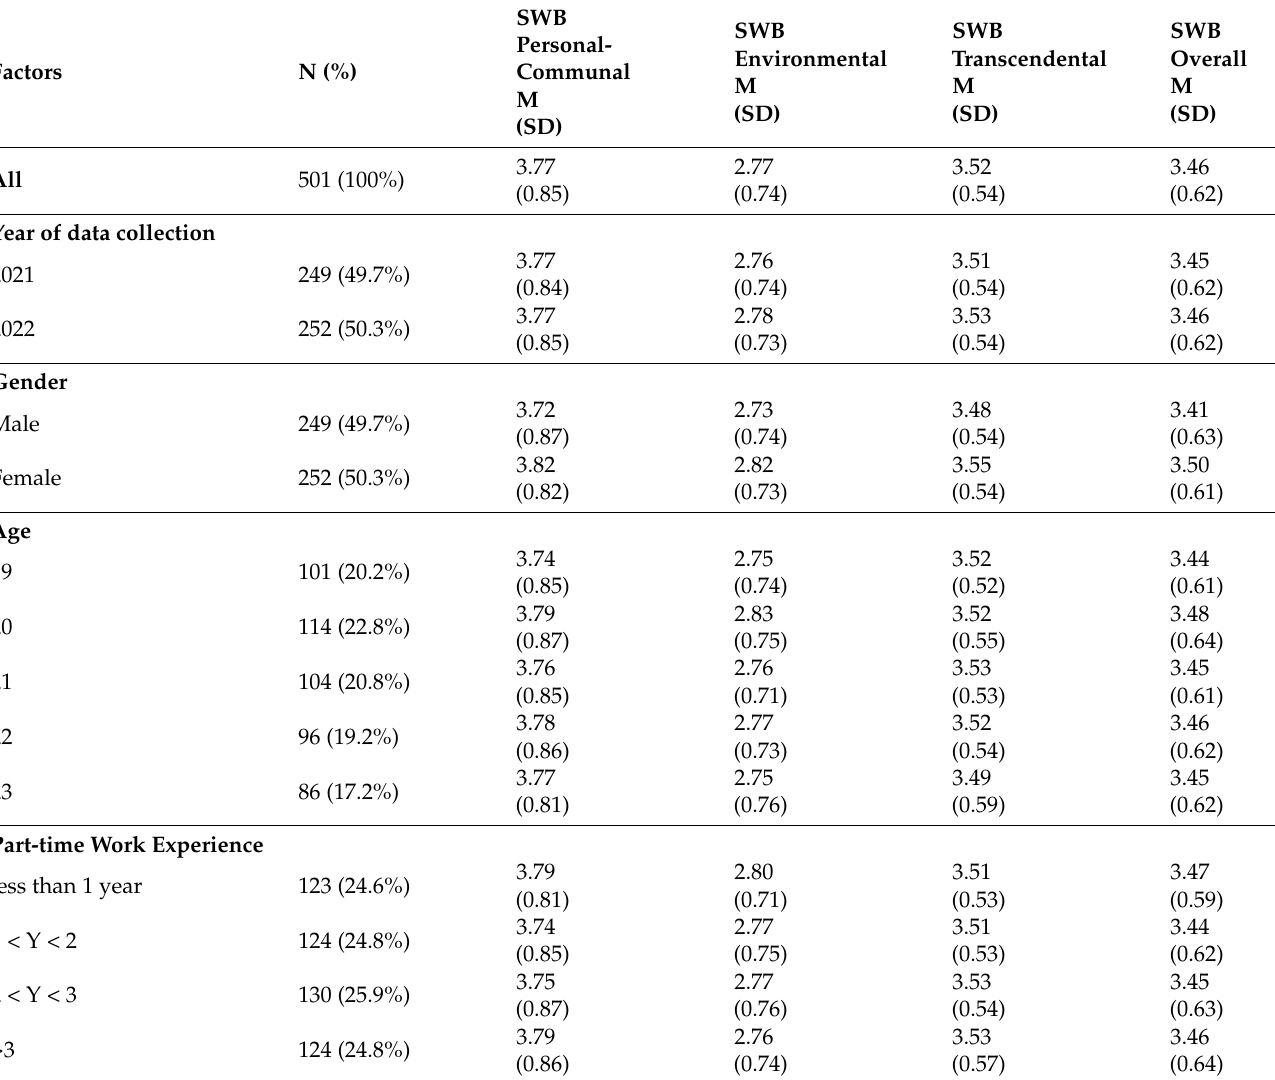
Table 3. Descriptive Statistics: Participants’ Demographics and their Relationship with Spiritual Well-being (N =